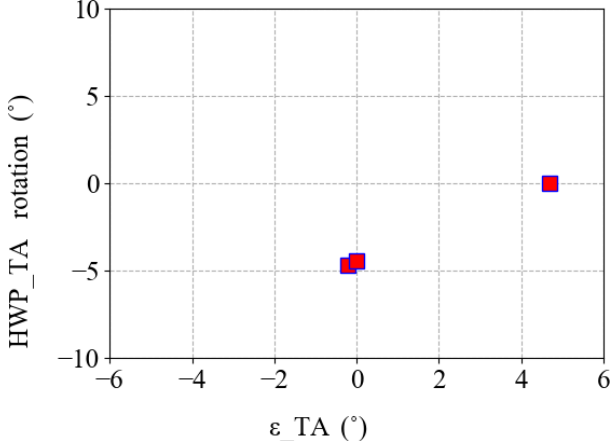
Figure B1. The test performed for zeroing ε TA and setting of θ TA = − ω TA , for the correction of I LA_TA_ s and I LB_TA_ s , for the rotation 2 of the detection unit after telescope